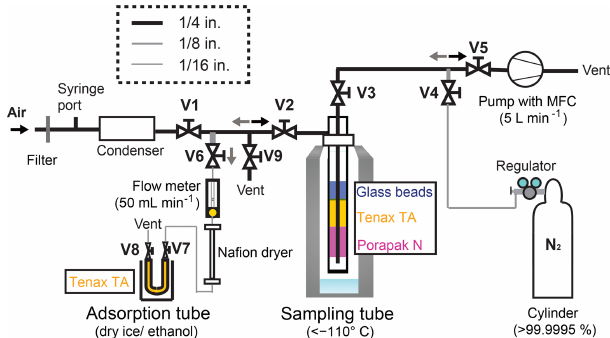
Figure 1. Schematic diagram of the OCS sampling system. Sys- tem components: V, valve; pump, vacuum pump; MFC, mass flow